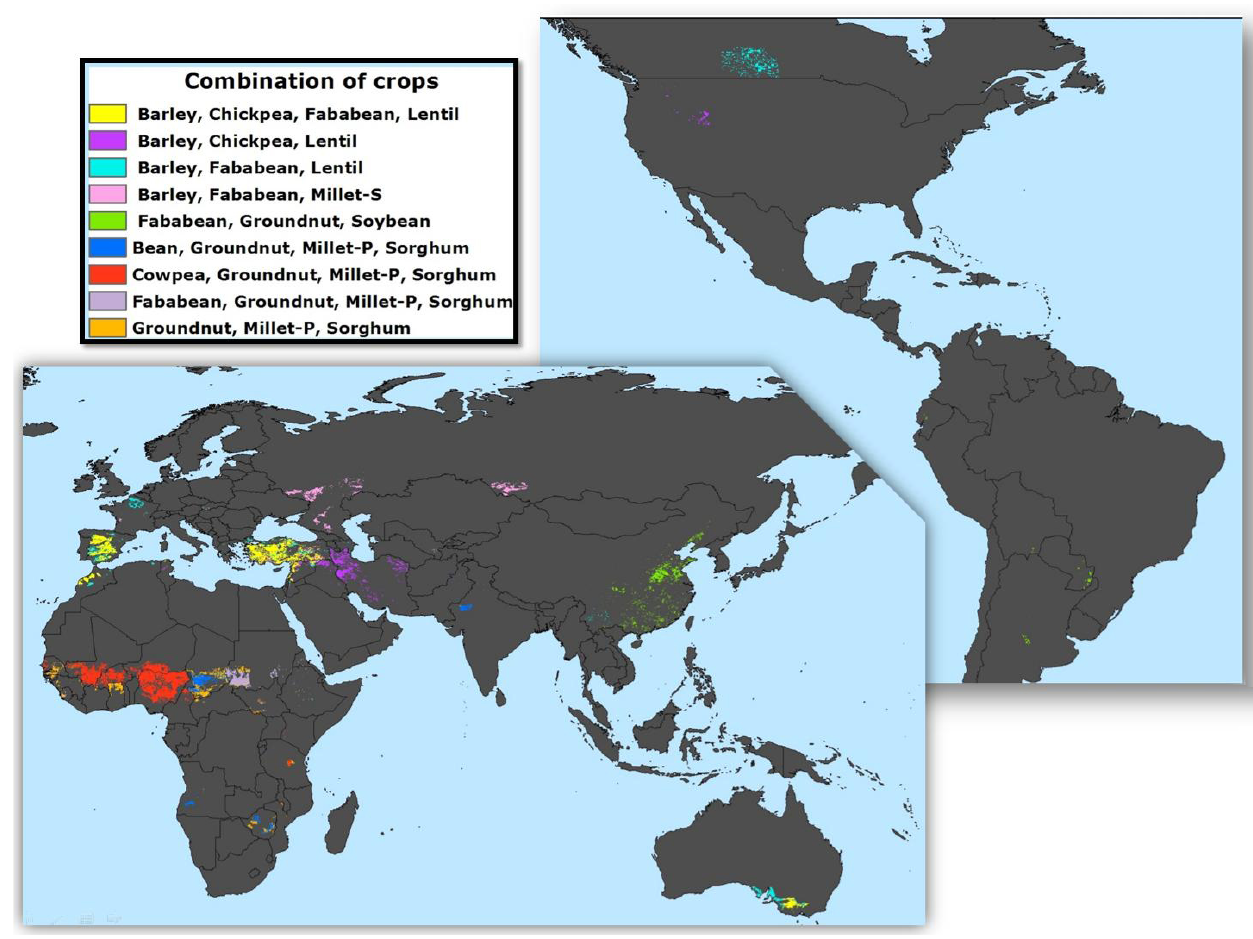
Figure 5. Crop combinations with the largest